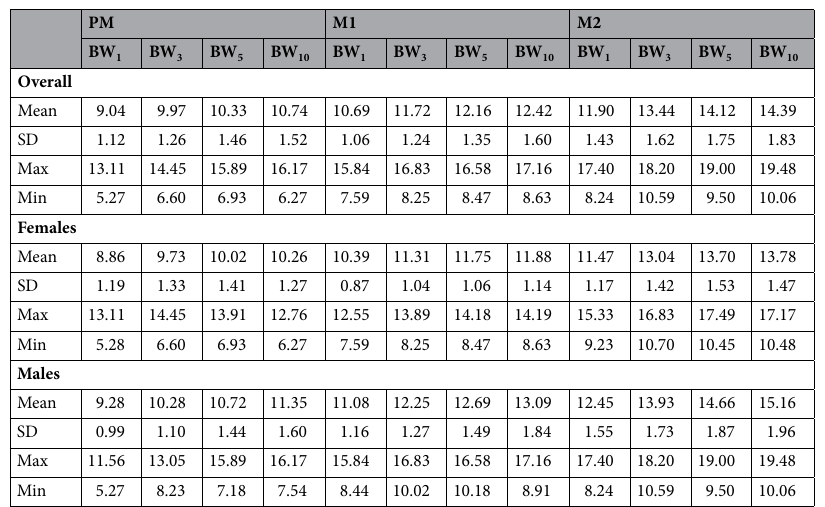
Table 1. Alveolar bone width (BW) measurements. PM: second premolar; M1: first molar; M2: second molar; BW1, BW3, BW5 and BW10: measurements taken at h 1 mm, h 3 mm, h 5 mm and h 10 mm.